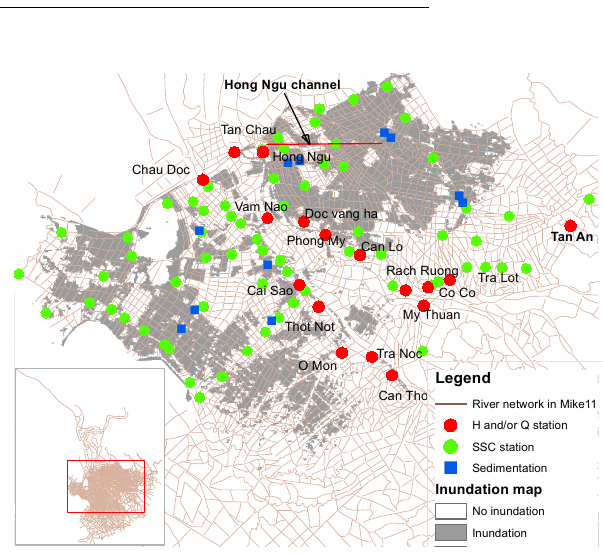
Figure 3. Locations of stations used for model